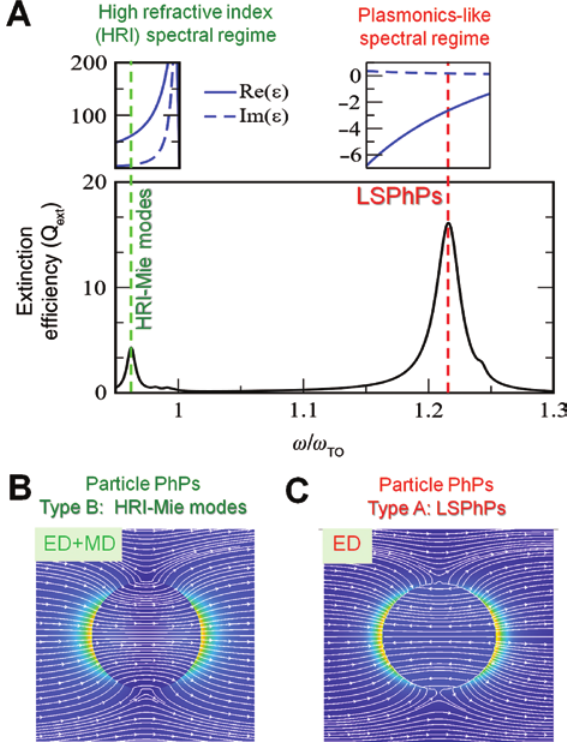
Figure 20: Ordinary particle